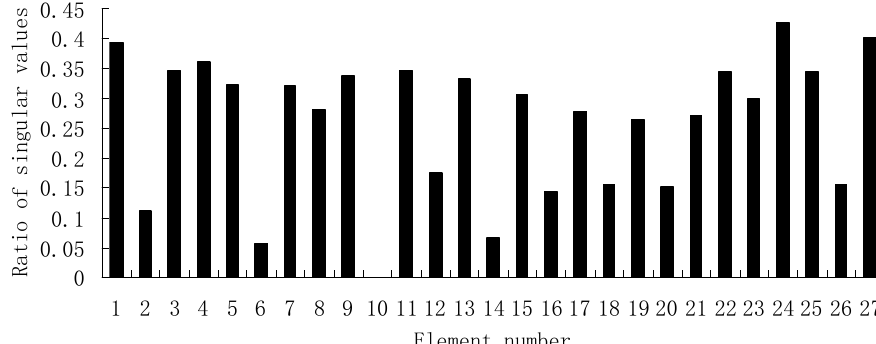
Table 2. The singular-values of the flexibility correlation matrix for each element.